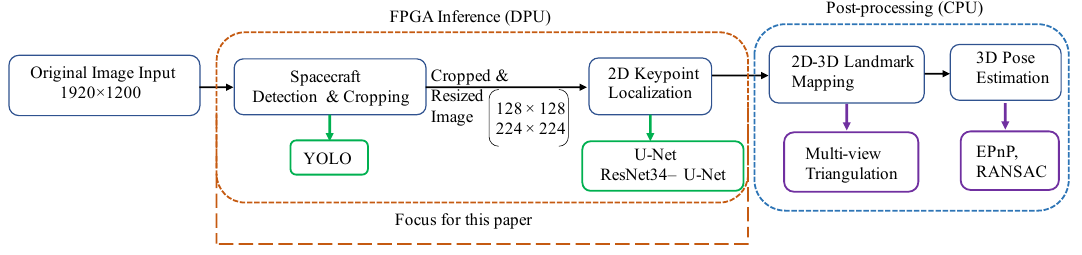
Figure 3. Onboard FPGA-based Implementation for CNN-based Pose